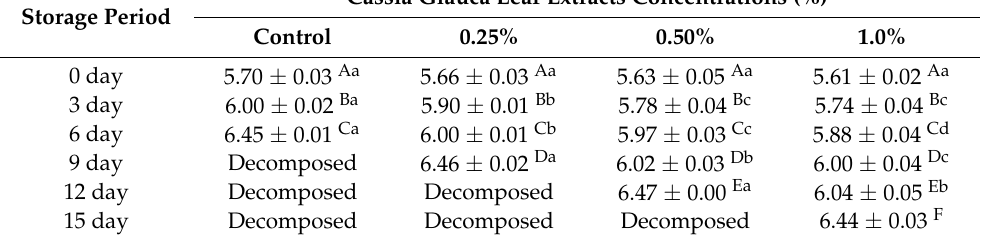
Table 6. Pattern of the aerobic bacterial count (log10 cfu/g) in minced beef treated with ethanolic Cas- sia glauca leaf extracts (0.25%, 0.5%, 1%) during the cold storage period at 3 ± 1 ◦ C (mean ± standard deviation “SD”).